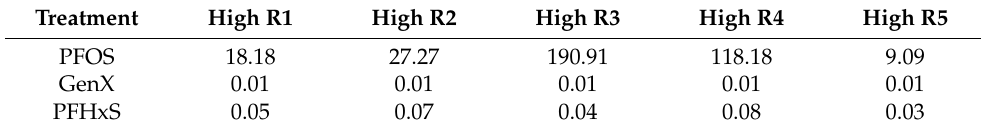
Table 6. Bioconcentration factors for each treatment of PFAS at a high concentration ( µ g/L). Treatment High